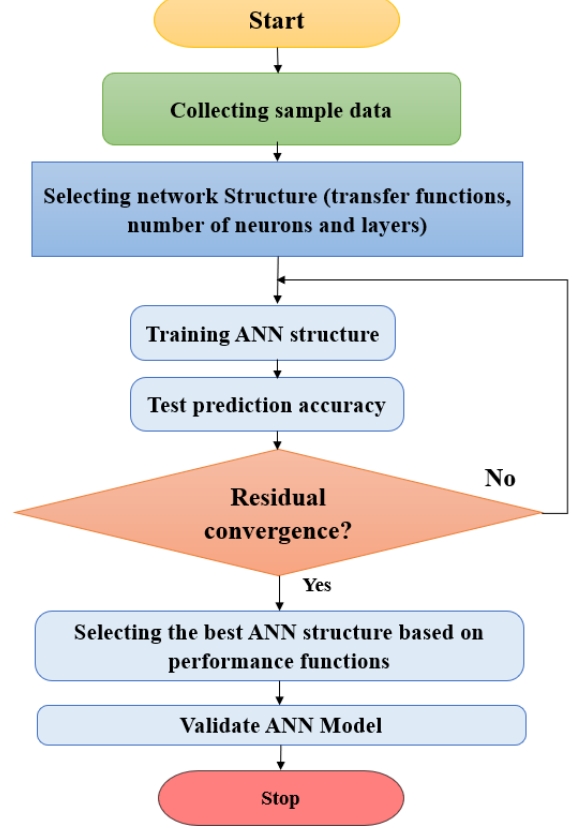
Figure 21. Modeling of the ANN.